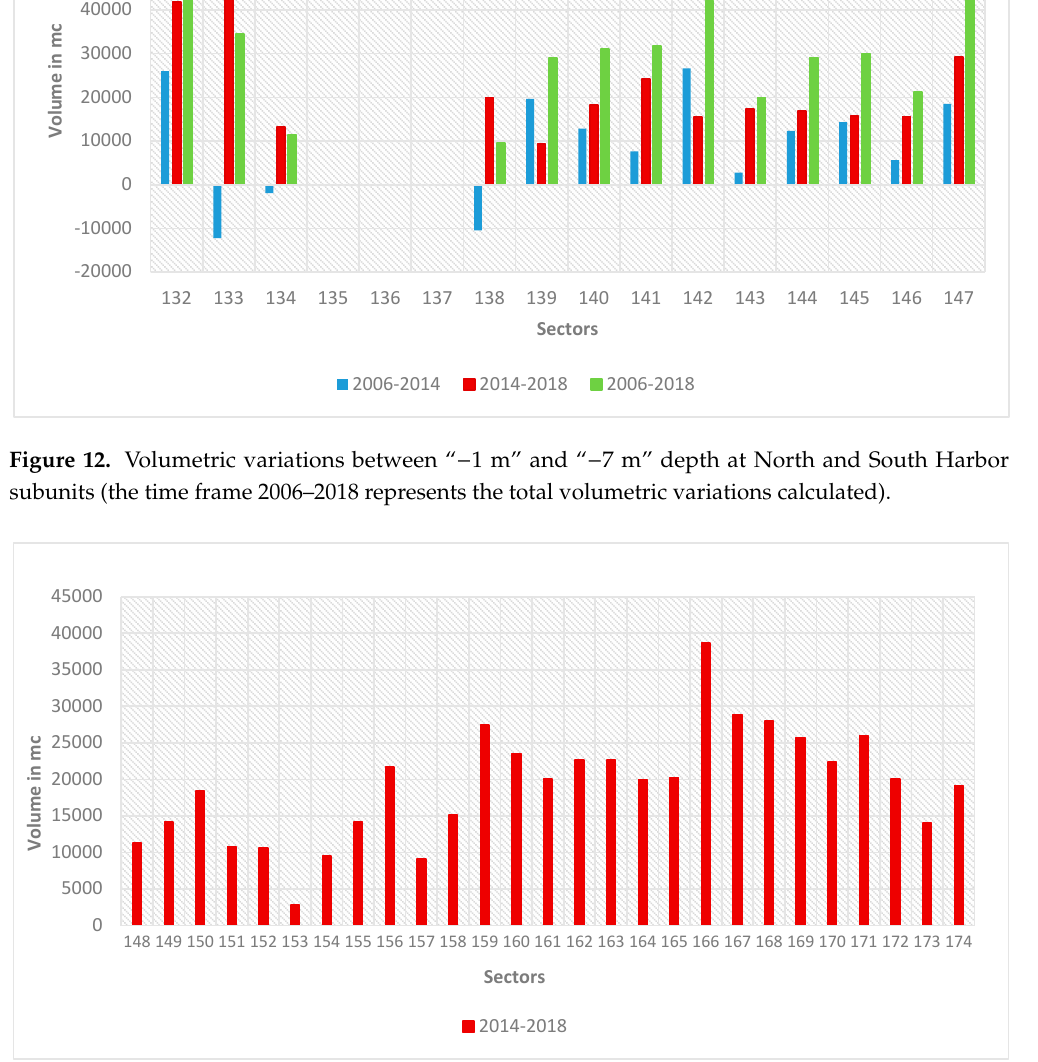
Figure 13. Volumetric variations between “ − 1m” and “ − 7m” depth at Southern subunit.